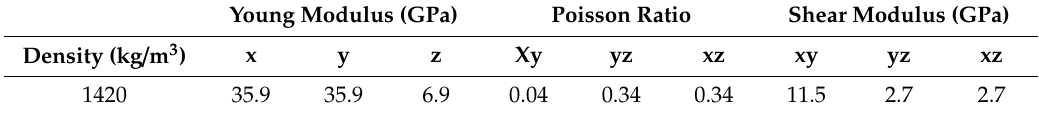
Table 1. Static mechanical properties of carbon fiber reinforced epoxy prepreg. Figure 5. Specimens ( a ) VBO and ( b ) autoclave.